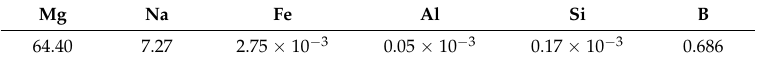
Table 5. Elemental concentration of purified solution (g/L).